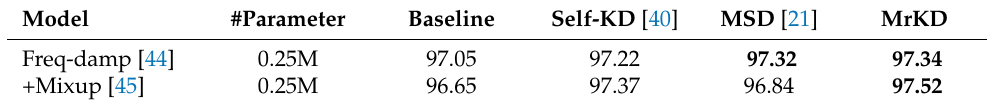
Table 8. Test accuracy comparison on DCASE’20 Low Complexity ASC [31] dataset .